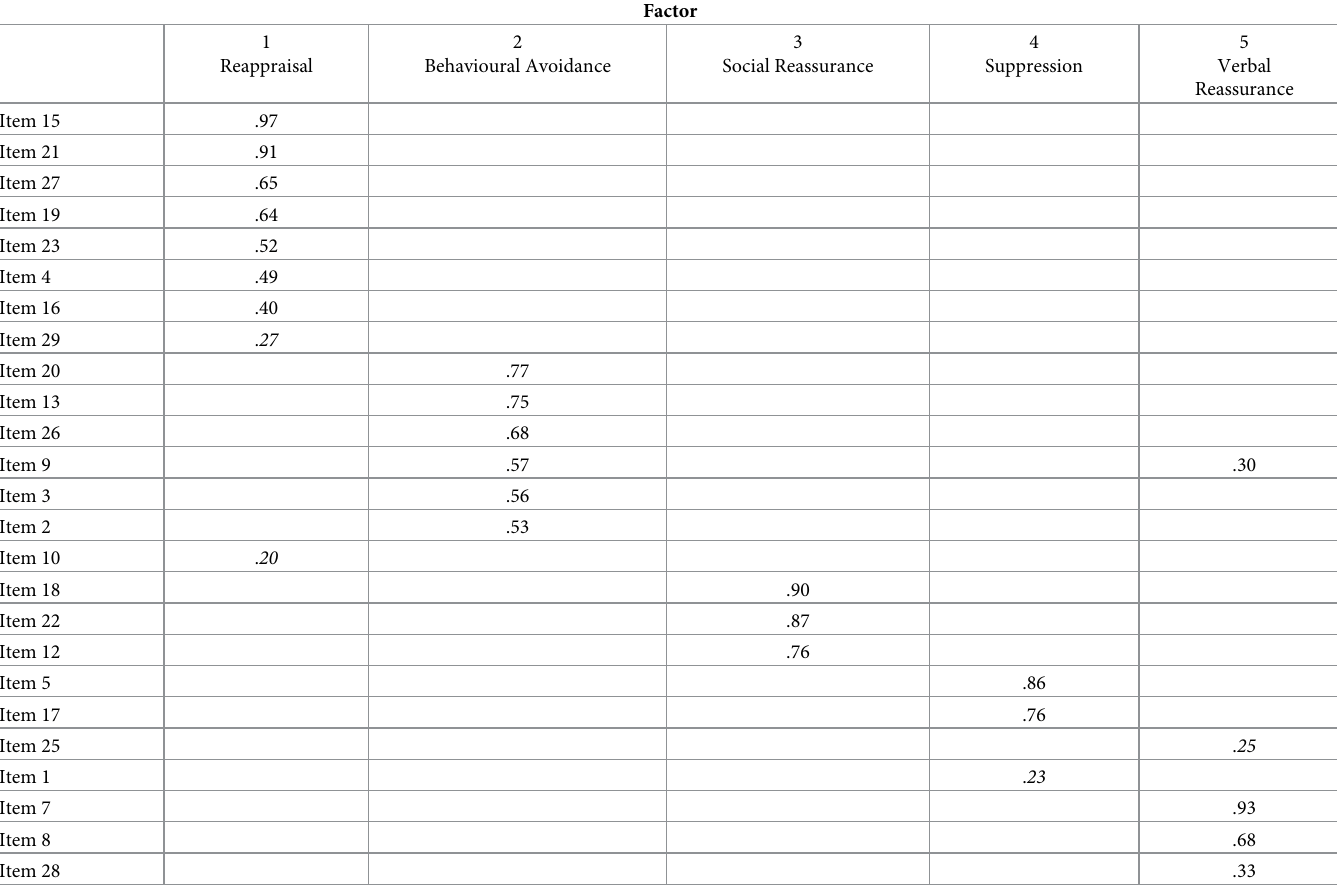
Table 2. Results of the exploratory factor analysis, maximum likelihood estimation, promax